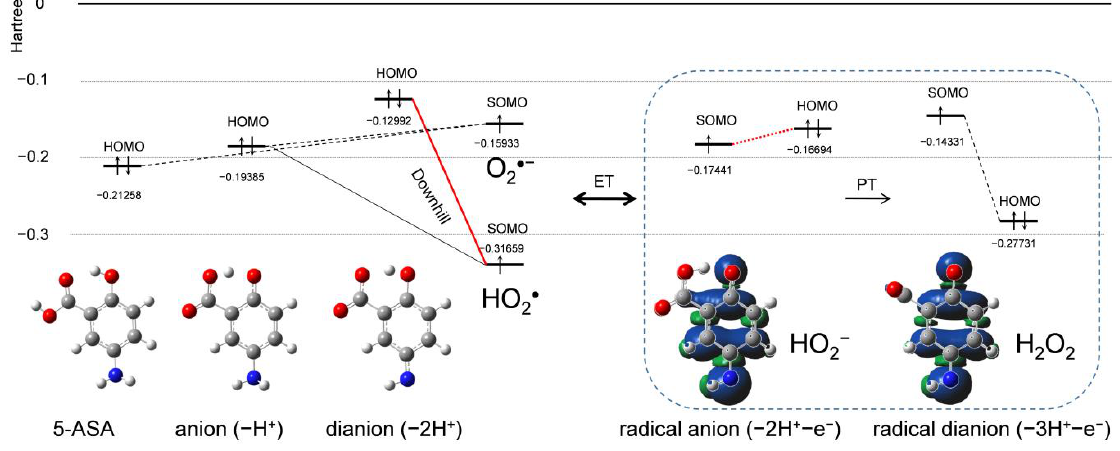
Figure 6. Changes in HOMO–LUMO energies (Hartree) upon proton-coupled electron transfer (PCET) between O 2•− and 5-ASA in DMF, calculated with the DFT-B3LYP/PCM/6-311+G(d,p) method.